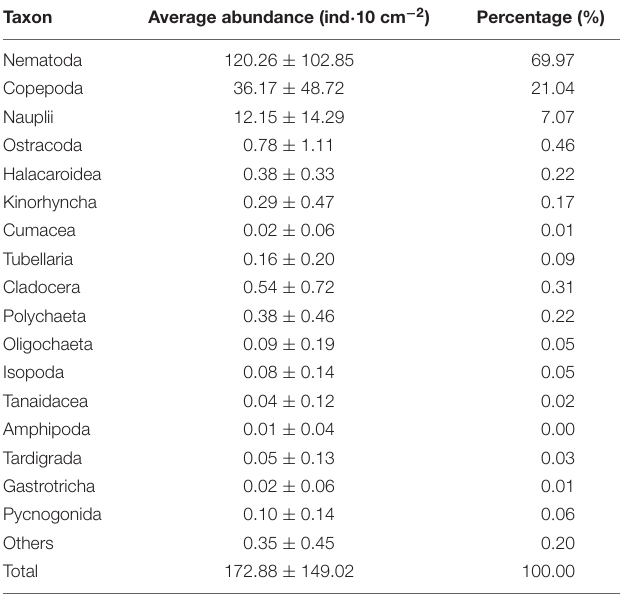
TABLE 3 | Abundance of each meiofaunal taxon in the adjacent areas of the Yap Trench, Western Pacific